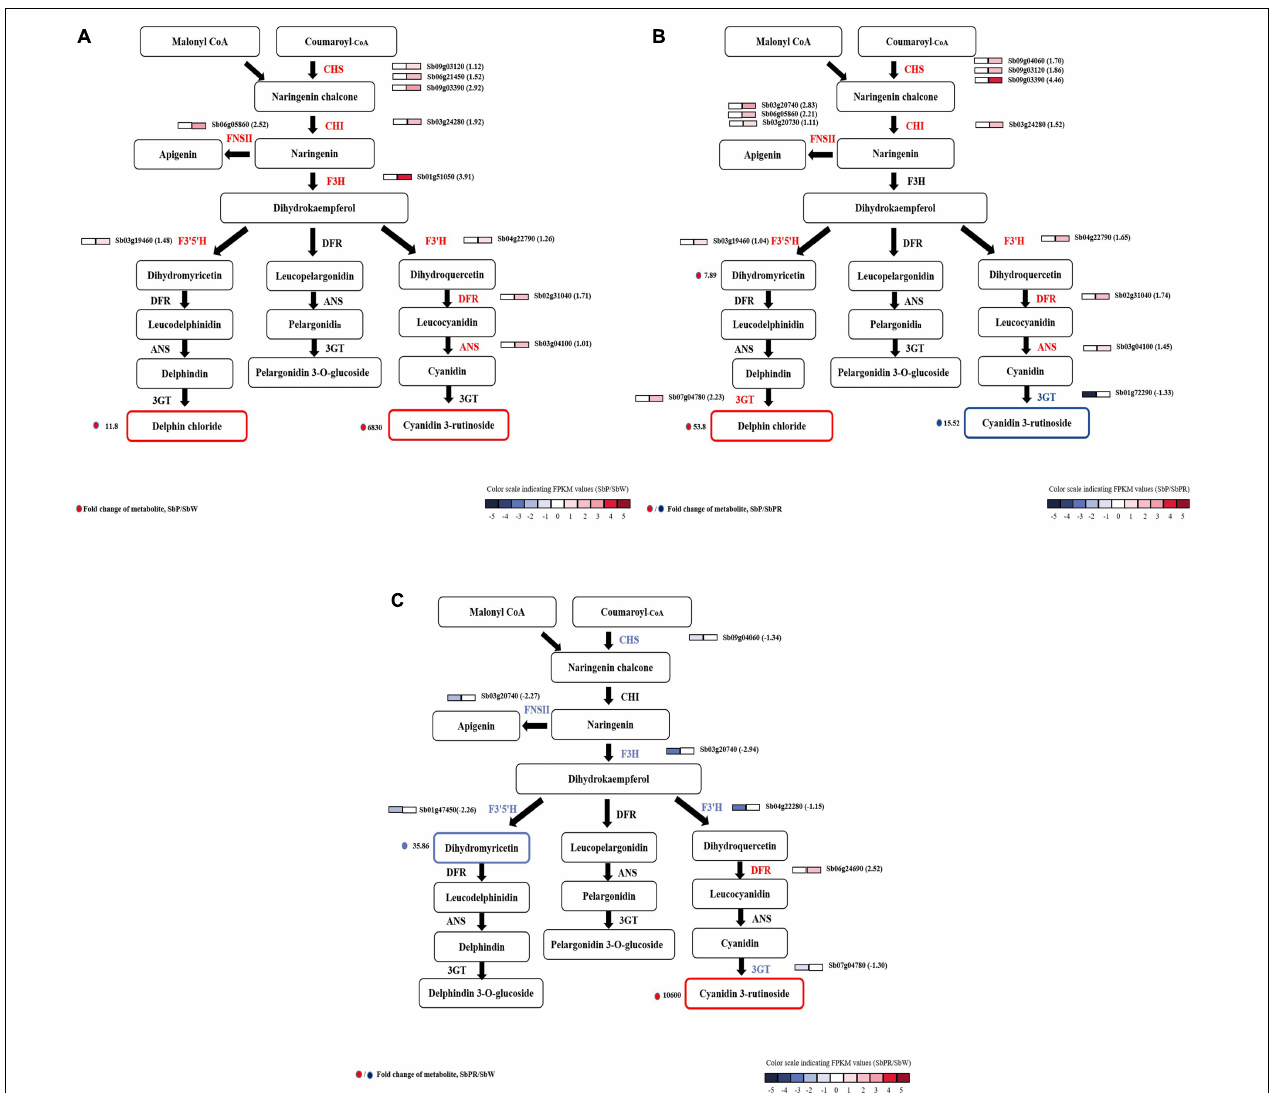
FIGURE 4 | Transcript profiling of genes related to the flavonoid synthesis pathway with different flower colors (SbP, SbPR, and SbW). The core schematic illustration of flavonoid synthesis in S . baicalensis flowers was constructed according to KEGG pathway analysis and published literature [ (A) SbP vs. SbW; (B) SbP vs. SbPR; (C) SbPR vs. SbW). The annotated flavonoid synthesis genes and the candidate genes for regulating anthocyanins synthesis in S . baicalensis flowers are shown in the figure with different colors. The grids with color-scale from dark to light indicate RPKM values; red and blue represent high and low abundances, respectively. Red or dark solid circles represent the log2 fold change in metabolites contents between three groups (SbP vs. SbPR, SbPR vs. SbW, or SbP vs. SbW). ANS, Anthocyanidin synthase; CHI, chalcone isomerise; CHS, chalcone synthase; DFR, dihydroflflavonol 4-reductase; F3 (cid:48) 5 (cid:48) H, flavonoid-3 (cid:48) ,5 (cid:48) -hydroxylase; F3H, flavanone 3-hydroxylase; FNS, flavone synthase; GT,